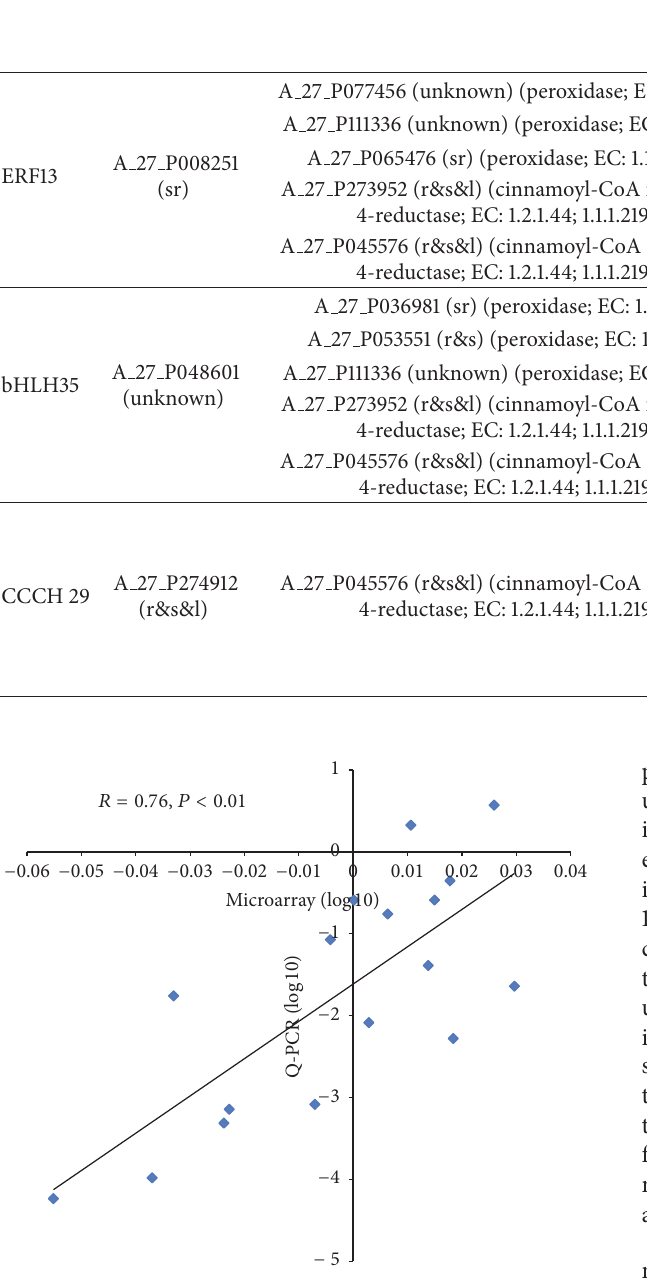
Figure 3: Relationship between microarray and qPCR data. The expression profiles of each gene based on the microarray data and qPCR were log 10 transformed. The microarray data were plotted against the qPCR